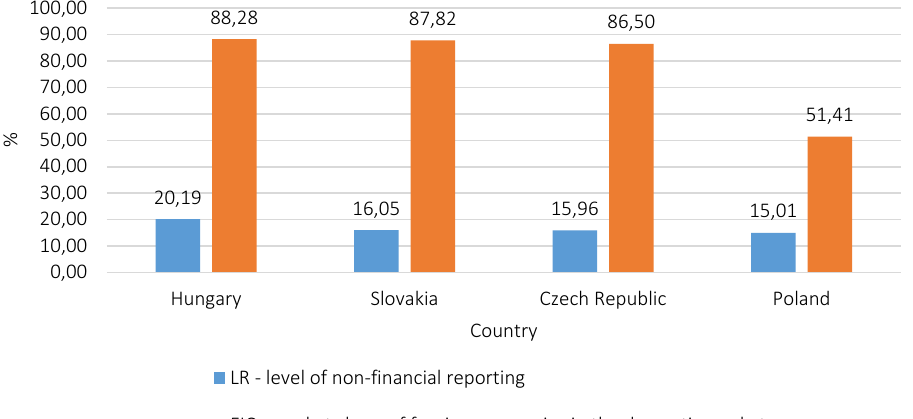
Figure 1. The relationship between the level of non-financial reporting and the share of foreign capital in the insurance market in the Visegrad Group